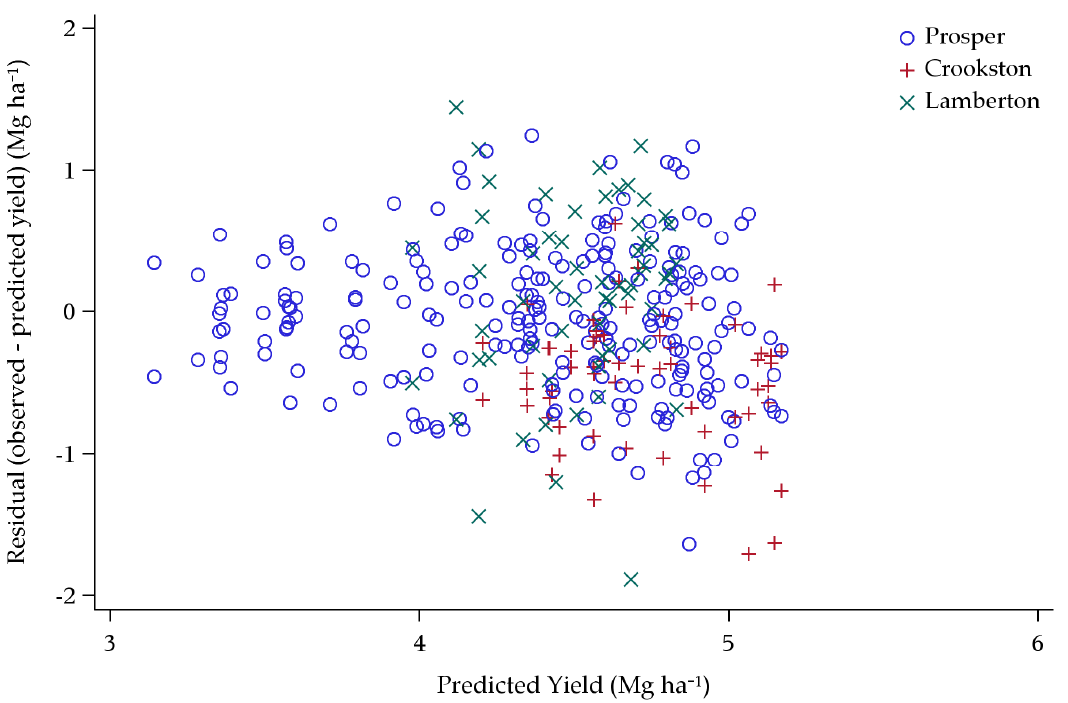
Figure 9. Validation dataset yield predictions plotted against residual yields (observed minus predicted yield) over the six lowest-yielding environments in Minnesota and North Dakota, 2013–2015.